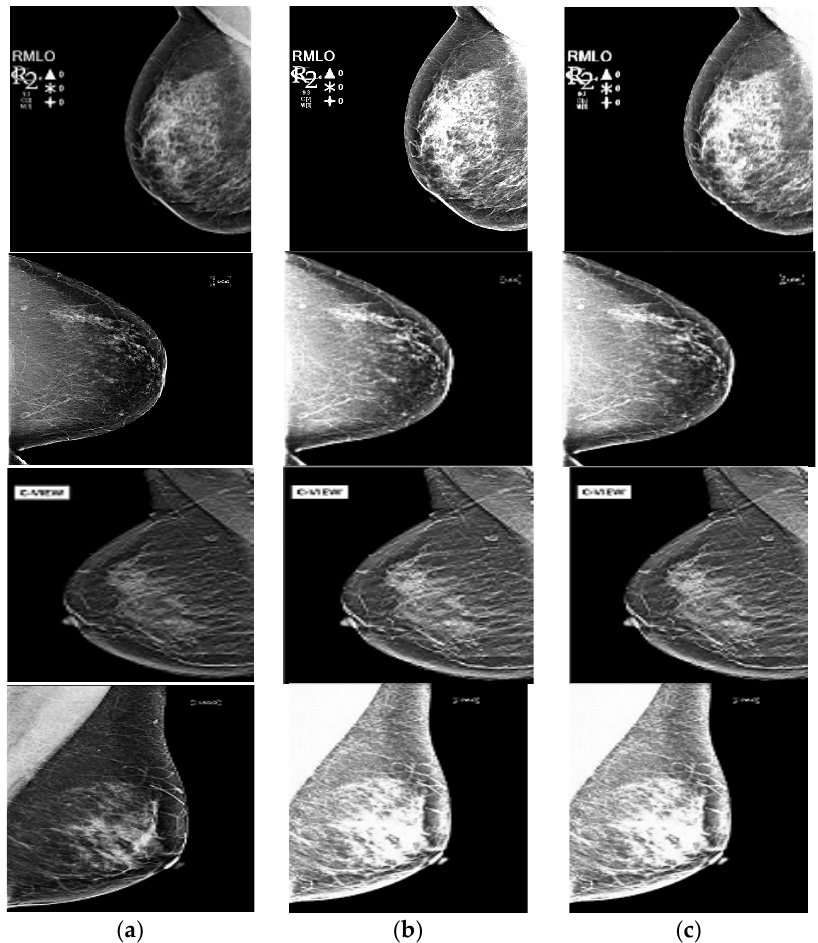
Figure 3. ( a ) Original images from MIAS, DDSM, and DBT Databases, ( b ) Enhanced Images obtained via Optimized S-curve Transformation, ( c ) Fused Images. Table 1. Quantification of Enhancement Response using E, EME, and AMBE.